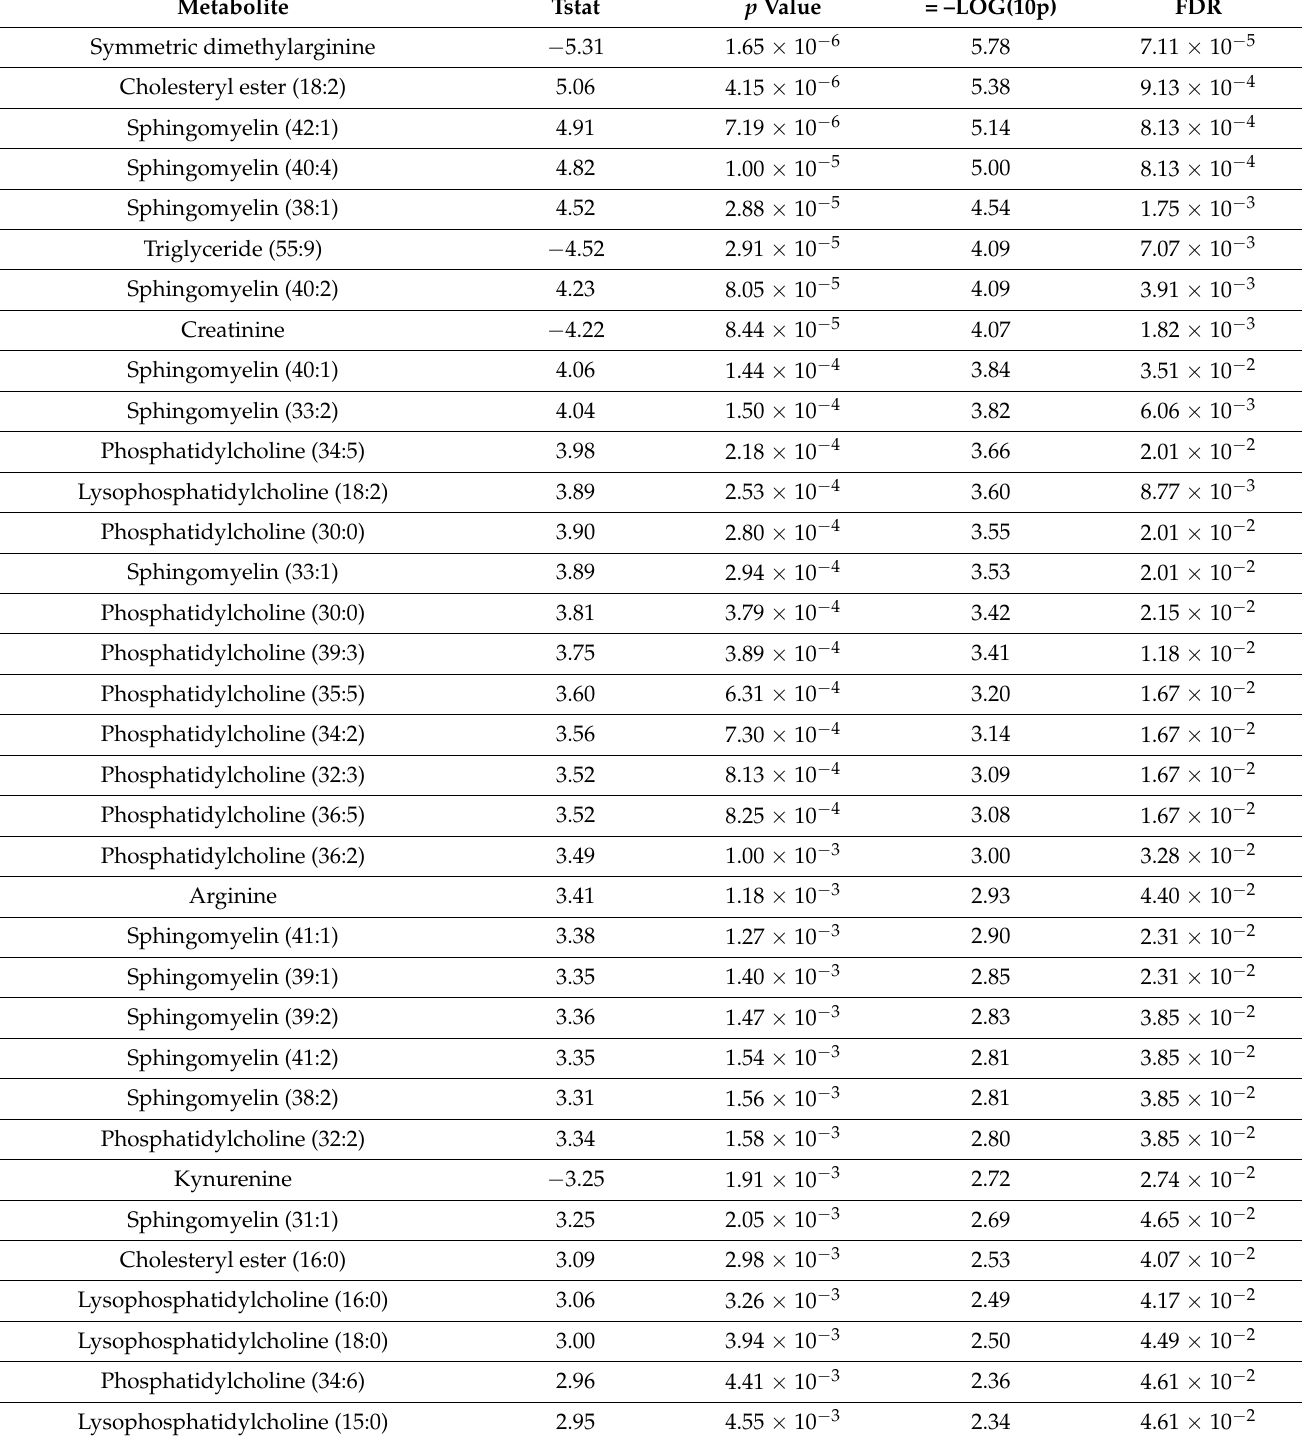
Table 3. Metabolites identified as significantly different in heart